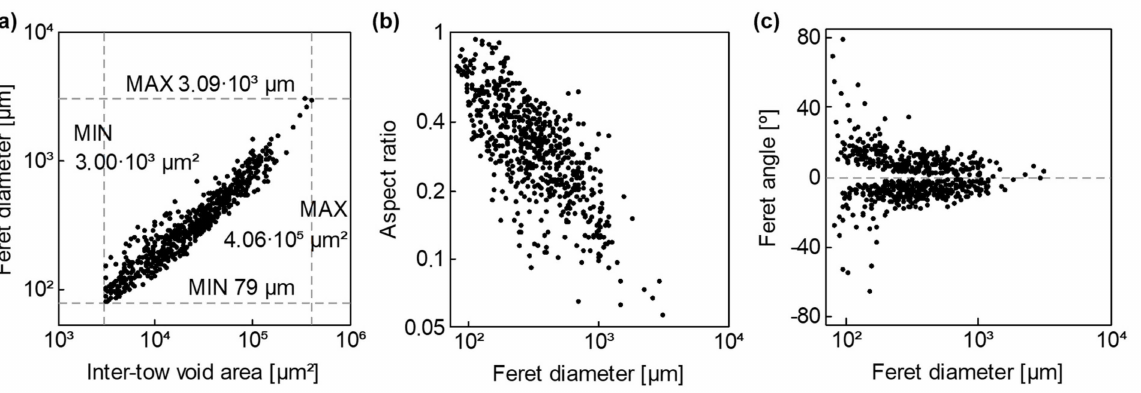
Figure 10. Shape descriptors of inter-tow voids: ( a ) Feret’s diameter, ∅ Feret ; ( b ) Aspect ratio, AR ; ( c ) Feret’s angle, ϕ Feret